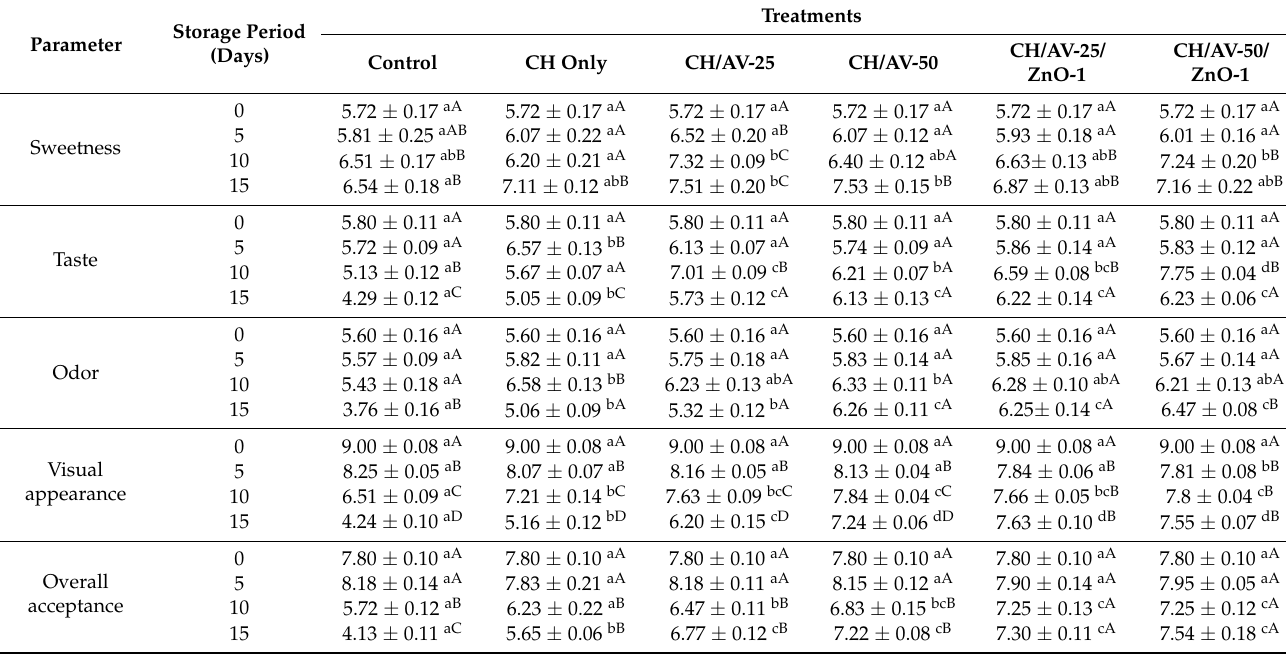
Table 3. Values for sensorial attributes of coated and uncoated pineapple fruits stored at ambient condition for 15 days.